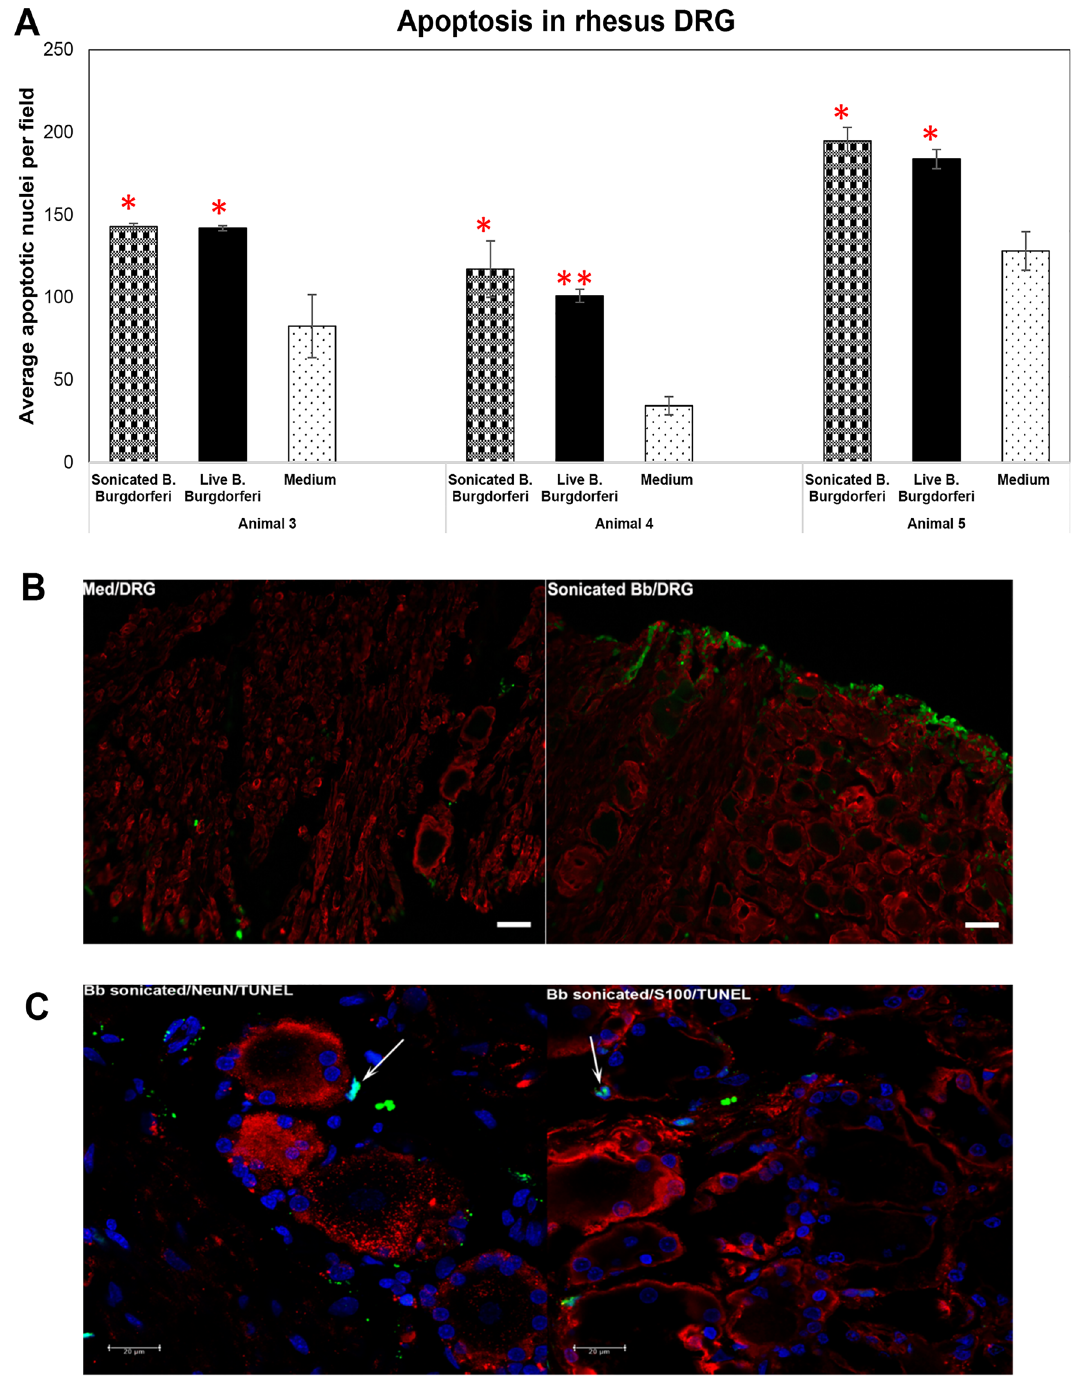
Figure 6. Apoptosis in the rhesus DRG in response to non-viable B. burgdorferi . Apoptosis data from three different rhesus DRG tissues in response to live or sonicated B. burgdorferi is shown ( A ). Red asterisks indicate statistically significant increases over medium controls. Bar represents standard deviation. ( B ) Immunofluorescence pictures (Animal 4) showing overall increase in apoptosis (green) in tissues exposed to sonicated B. burgdorferi in comparison to the tissue sections that received medium only. Bar represents 50 µm. ( C ) confocal images (Animal 5) showing colocalization (cyan, arrows) of TUNEL positive nuclei (green) with DAPI (blue), seen in tissue sections also stained for neurons (NeuN, red) or glial cells (S100, red). Positive apoptotic nuclei are seen only in S100 positive or non-neuronal